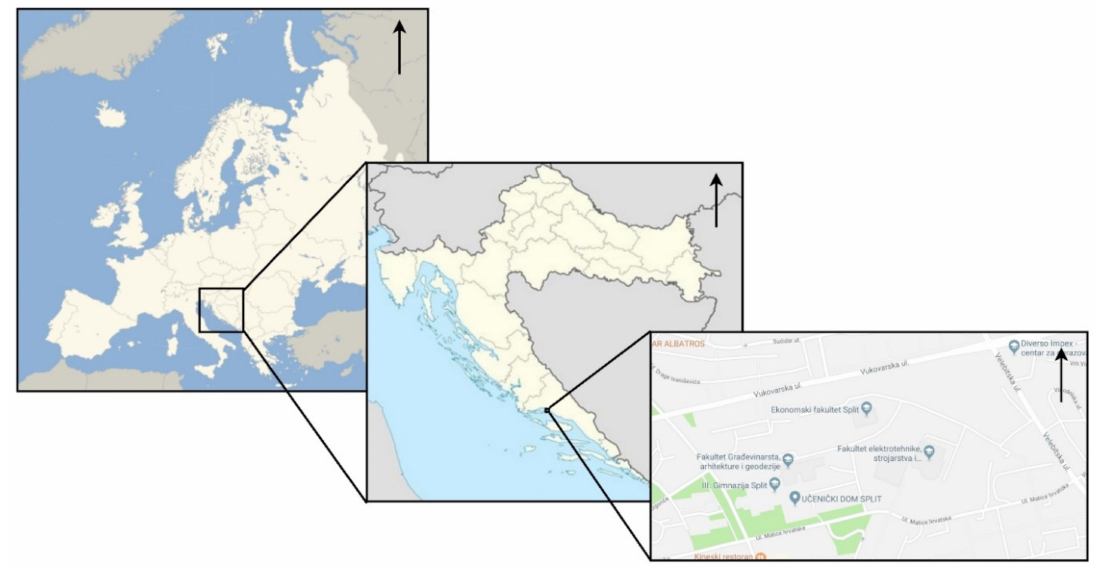
Figure 4. The University of Split Campus in the city of Split, Republic of